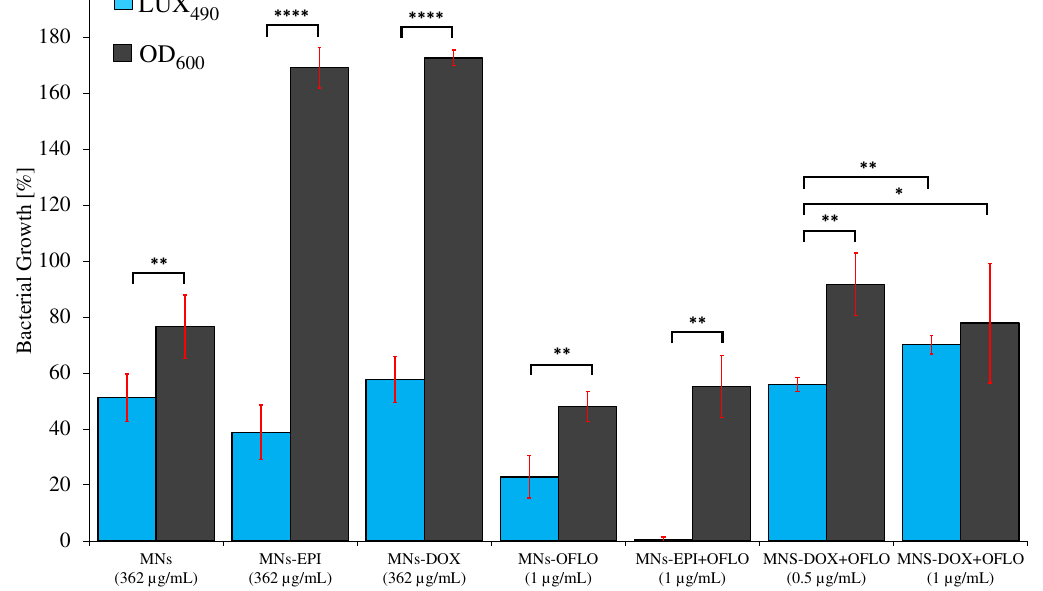
Figure 7. Statistical comparison of the obtained relative growth reduction, via OD 600 24 h-assaying the parental E. coli and LUX 490 8 h-assaying E. coli Lux, for all MNs’ systems (concentrations related to nanoparticle); statistically significant levels represented as * p ≤ 0.05, ** p ≤ 0.01, and **** ≡ p ≤ 0.0001.